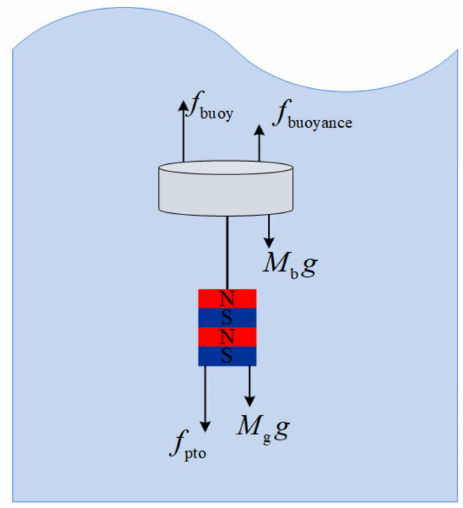
Figure 3. Analysis of force in